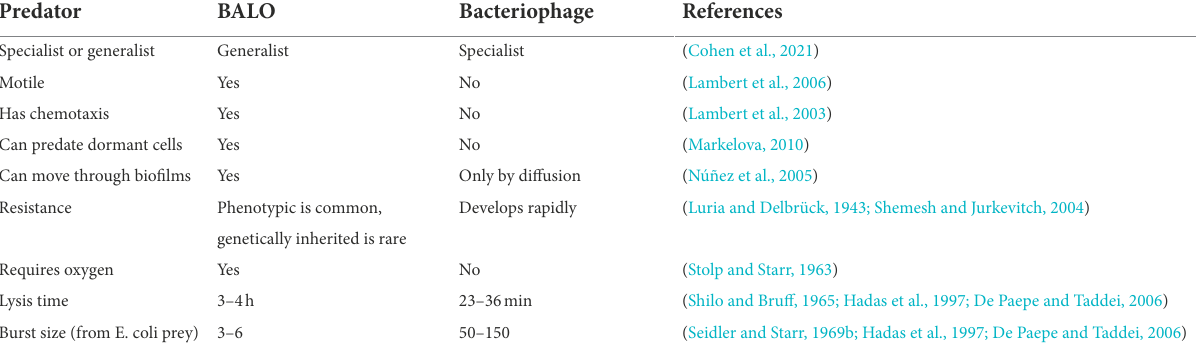
TABLE 1 Comparison of the properties of BALOs and bacteriophage regarding treating bacterial infections.